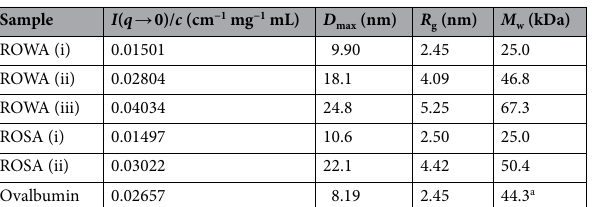
Table 4. Summary of the SAXS results of ROWA and ROSA. a Ovalbumin was used as a reference standard of the molecular